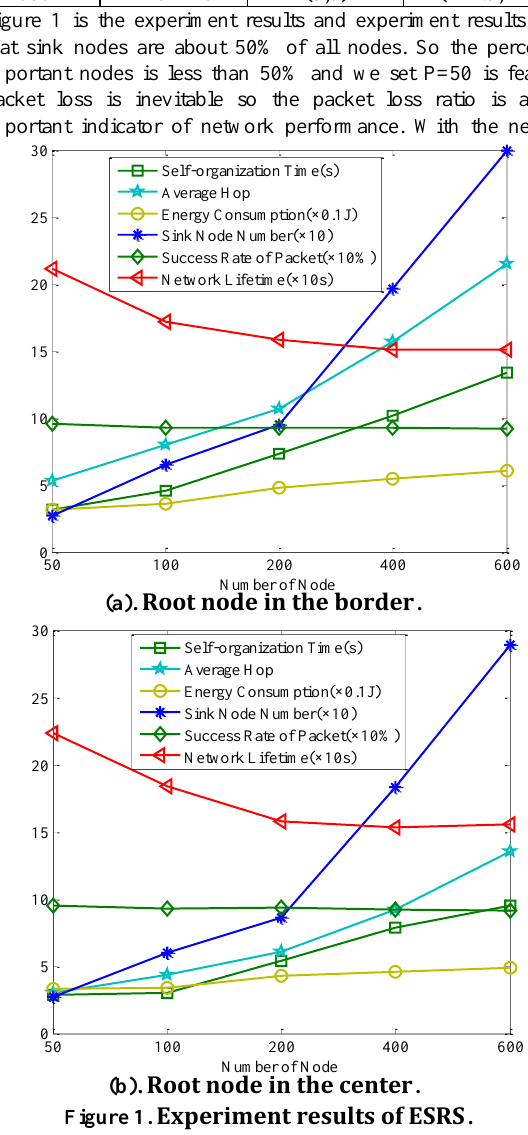
Figure 1. Experiment results of ESRS